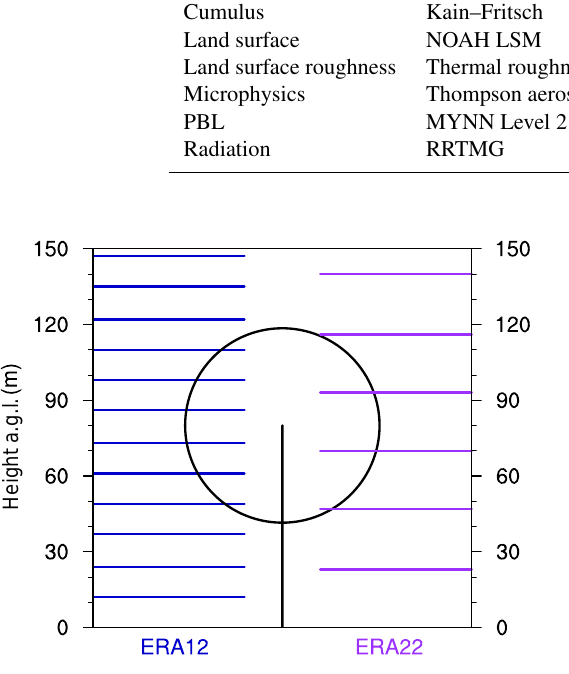
Figure 2. Illustration of the two vertical grids chosen: the 12m grid on the left in blue and the 22m grid on the right in purple. Both grids shown use the ERA-Interim as the boundary conditions. The simulations initiated with the 0.5 ◦ GFS have similar vertical grids.